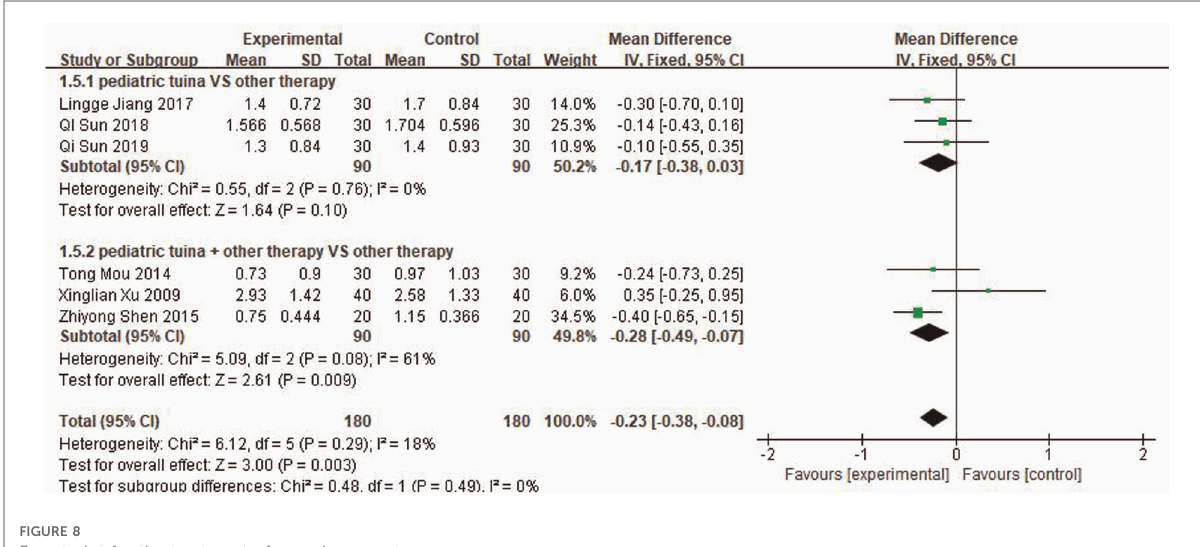
FIGURE 8 Forest plot for the treatment of sneezing symptom.